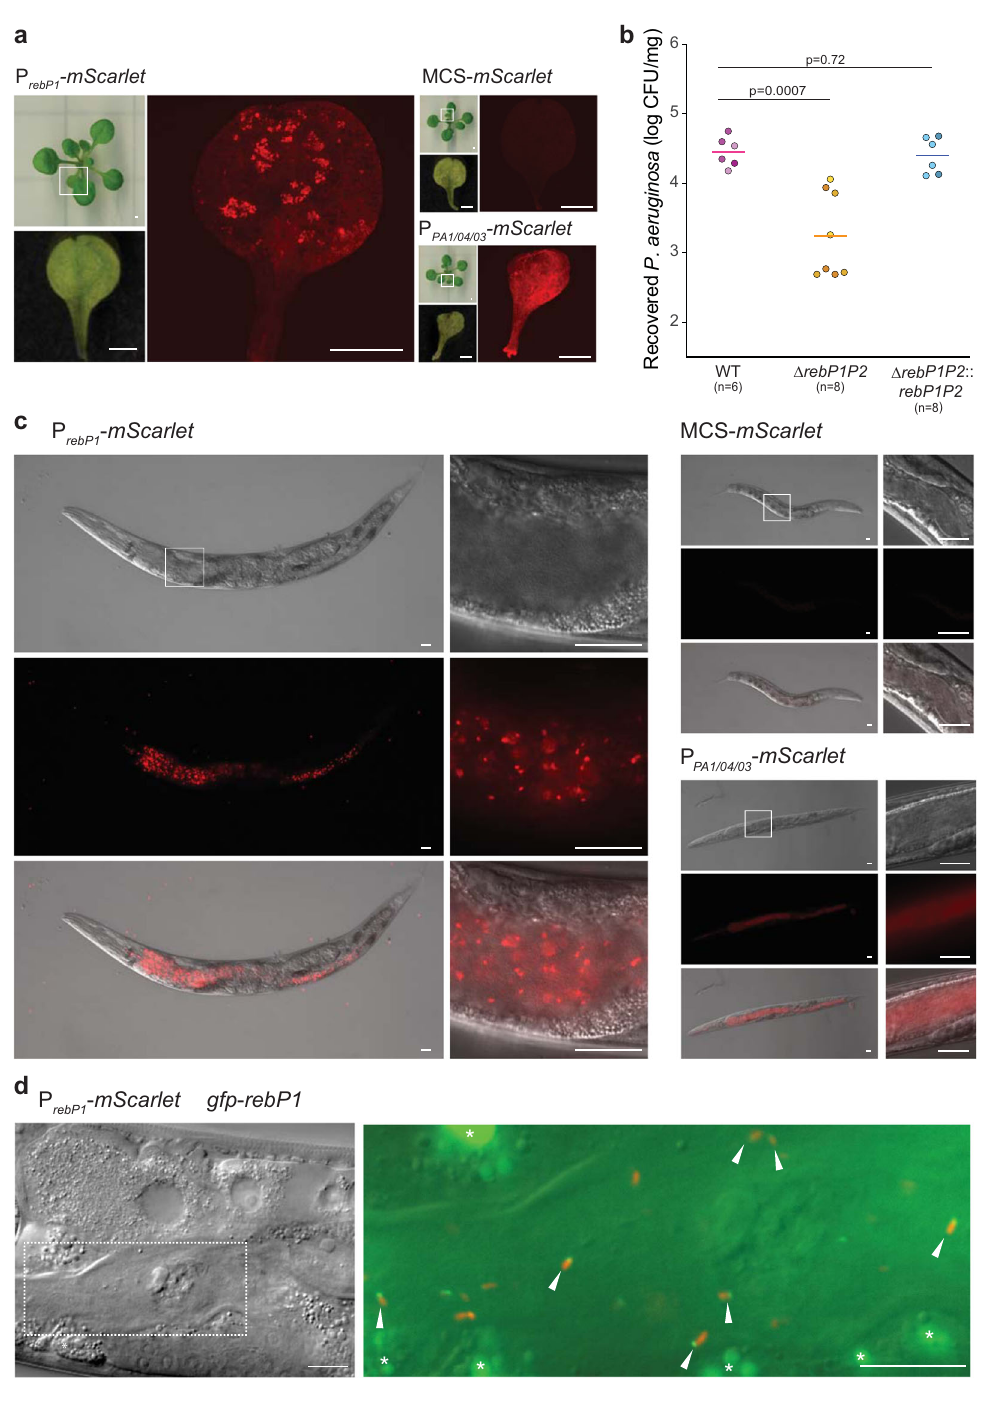
Fig. 5 R-bodies are produced during host association and contribute to colonization. a Fluorescent micrographs of A. thaliana leaves infected with WT PA14 expressing mScarlet under the control of the rebP1 promoter (P rebP1 - mScarlet ), no promoter (MCS -mScarlet ), or a constitutive promoter (P PA1/04/03 - mScarlet ). Smaller panels show images of the whole seedling and the imaged leaf indicated by the white box. Images are representative of nine biological replicates from three experiments. Scale bars are 1 mm. b CFUs obtained from A. thaliana seedlings inoculated with the indicated genotypes and incubated for fi ve days, normalized to seedling weight. Each circle represents a biological replicate, with color intensity indicating replicates from the same experiment; colored lines indicate means. p values were calculated using unpaired, two-tailed t -tests. n ≥ 6 biological replicates from three experiments. c Images of C. elegans fed WT PA14 containing the indicated reporter constructs. Top panels, Nomarski; middle panels, fl uorescence; bottom panels, overlay. White boxes indicate regions shown in close-up images. Images are representative of 15 replicates from three experiments. Scale bars are 10 µ m. d Images of C. elegans fed WT PA14 containing indicated transcriptional and translational reporter constructs (construct schematics are shown in Fig. 4a). Left: Nomarski image. Dotted white box indicates region shown in close-up image at right. Right: Nomarski image overlain with red and green fl uorescence micrographs. Arrows indicate single PA14 cells in the worm intestine showing both mScarlet and GFP fl uorescence. Asterisks (*) indicate auto fl uorescent granules in the gfp channel. Scale bars are 5 µ m. Images are representative of 15 replicates from three